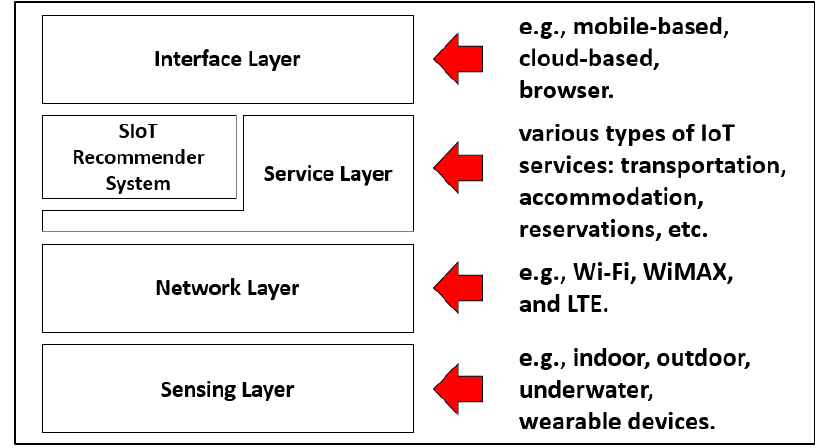
Figure 2. Proposed SIoT architecture with the recommender module.